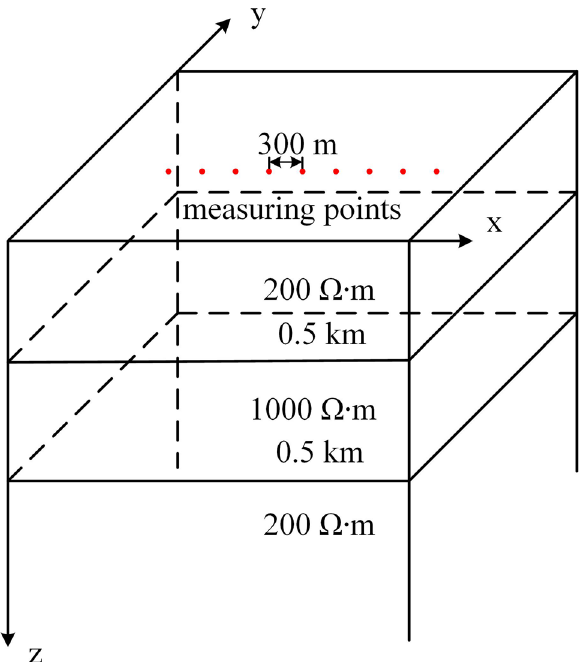
Figure 5. Three-dimensional layered geoelectric model.